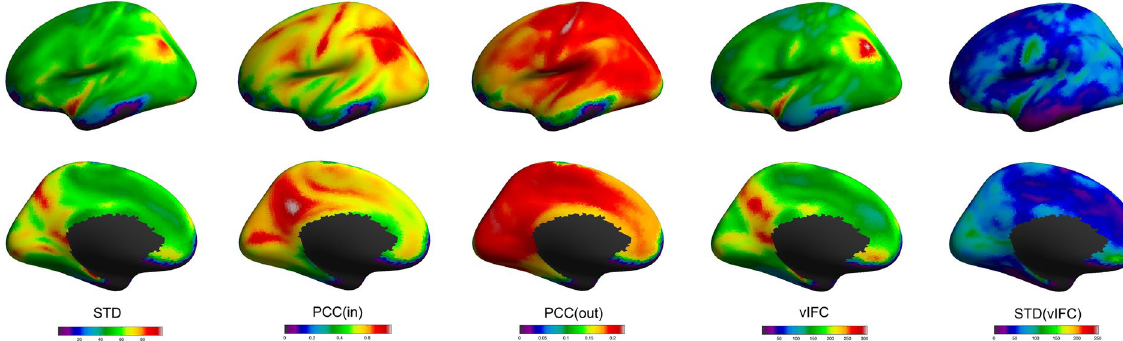
Figure 1. vIFC patterns and its three components in healthy populations. The five columns respectively correspond to the average maps of standard deviation of BOLD time series (STD), within cluster correlation (Corr(in)), outside cluster correlation (Corr(out)), vIFC and individual variability of vIFC (STD(vIFC)) across healthy